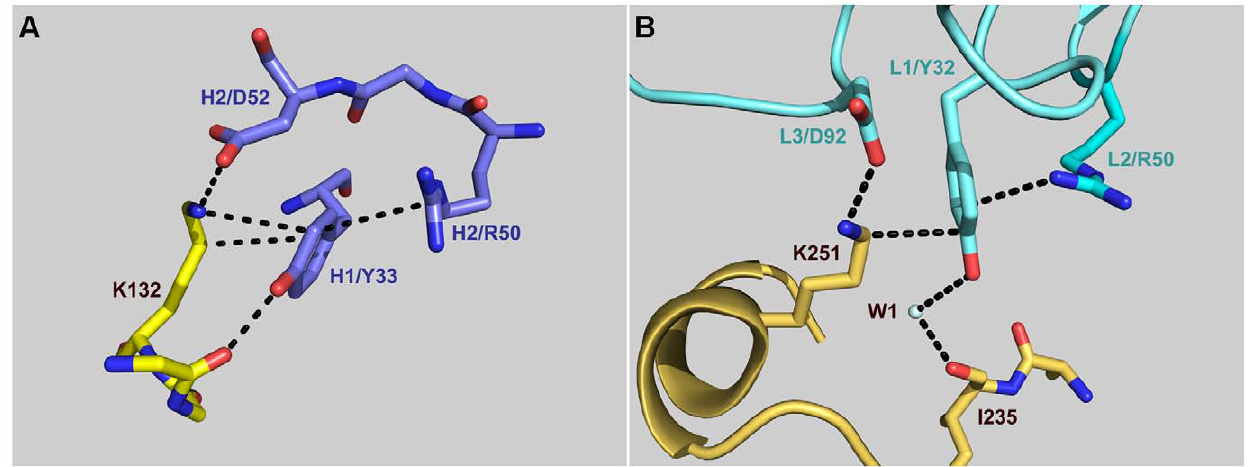
Figure 9. Structural environment of the lysine residues involved in cation- p interactions important for antibody binding. A) Lysine 132 interacting with the tyrosine 33 of the heavy chain of the mAb 7C11. B) Lysine 251 interacting with the tyrosine 32 of the light chain of the mAb 4C3.